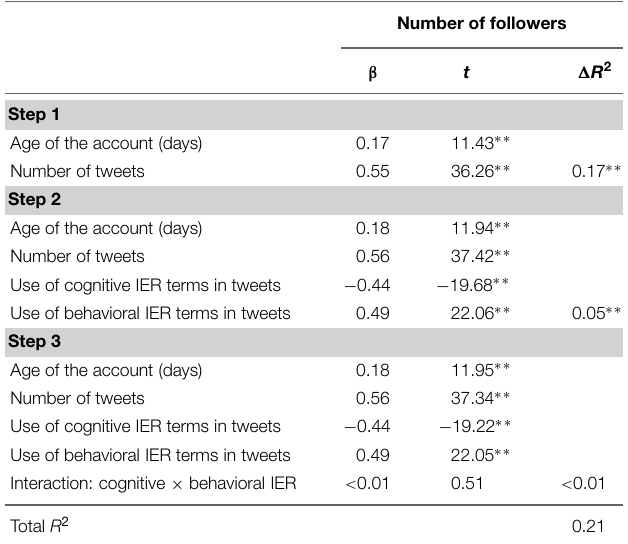
TABLE 4 | Regression analysis predicting Twitter popularity in Study